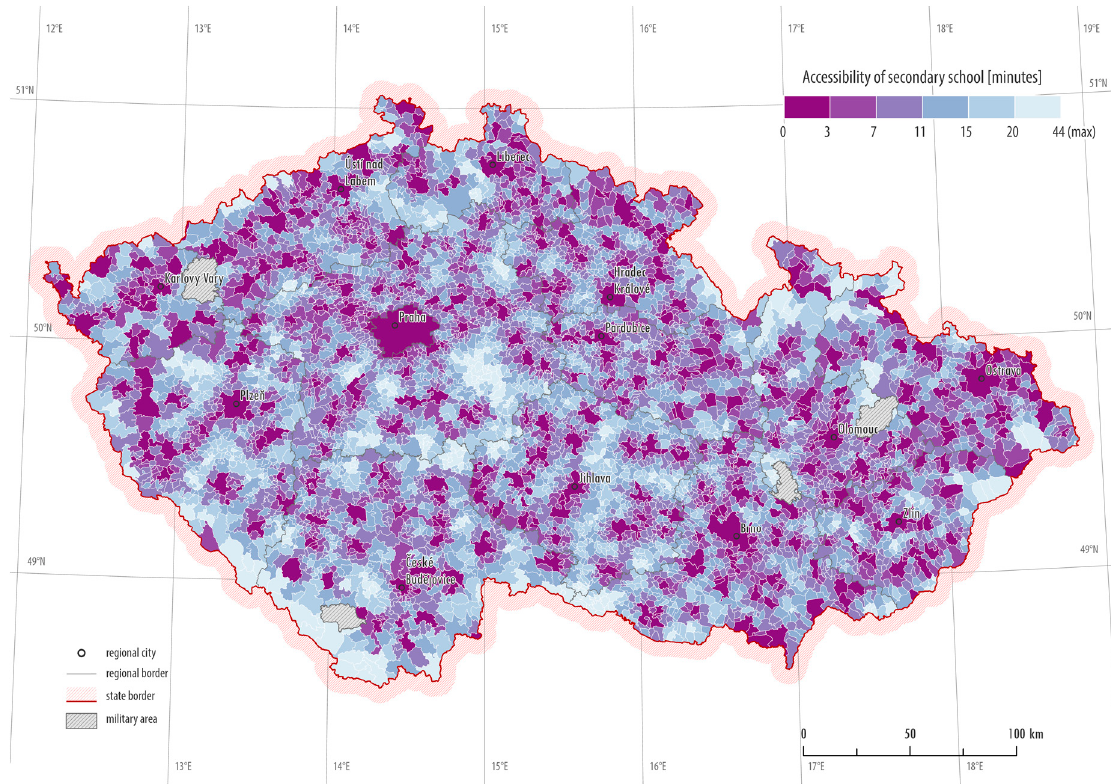
Figure A3. Accessibility of secondary